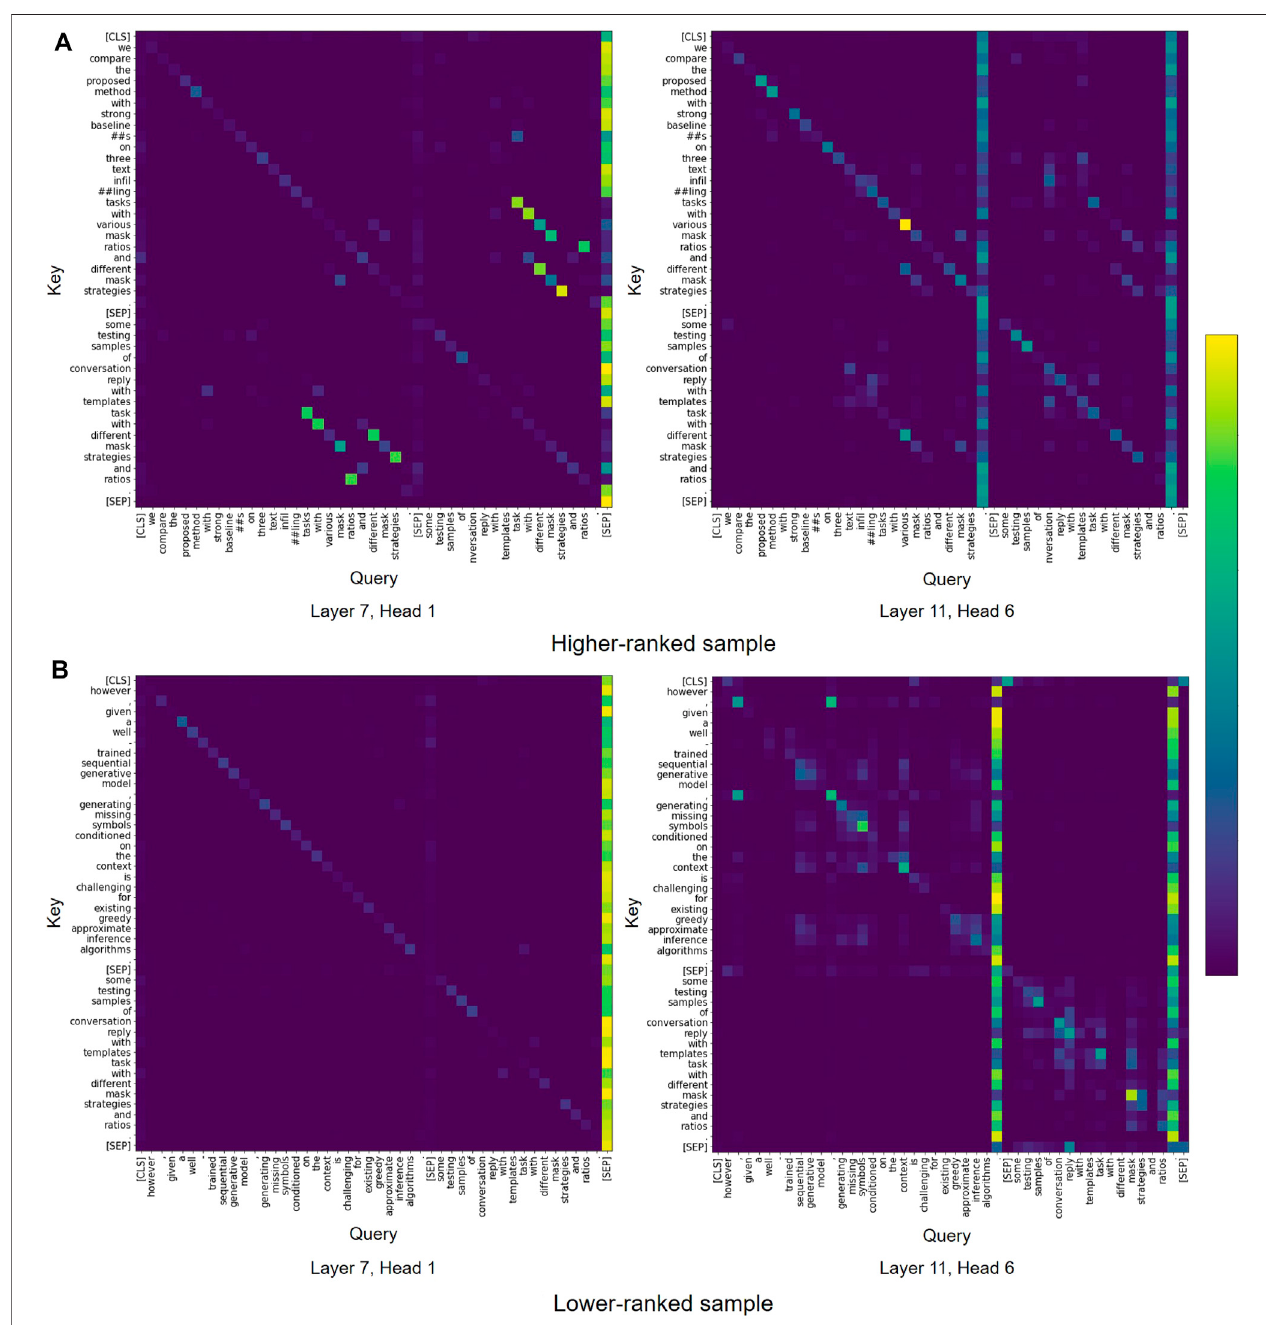
FIGURE 6 | Examples of attention patterns in SciBERT model for (A) higher-ranked sample and (B) lower-ranked sample.